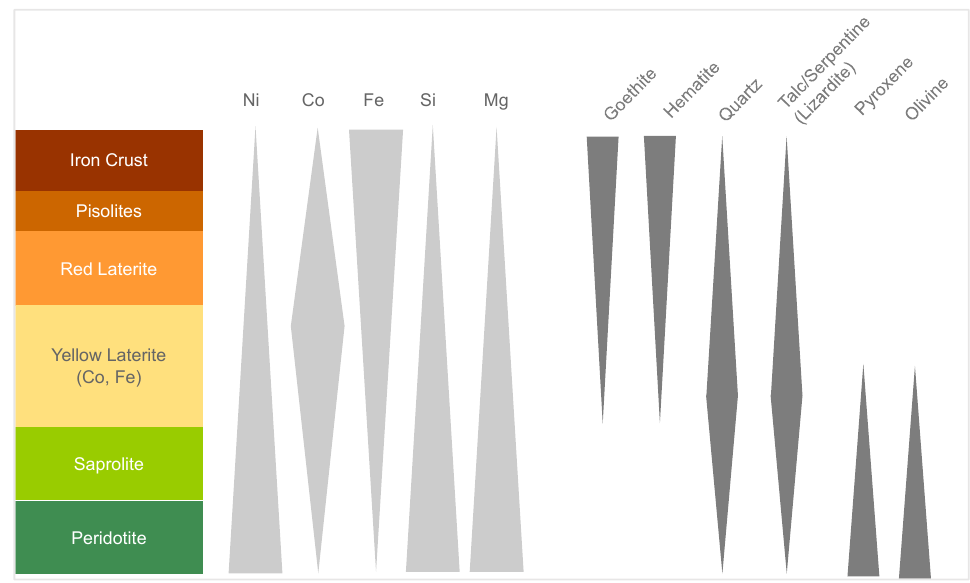
Figure 2. Schematic hydrous Mg-Si-silicate laterite profile modified after [12,13].